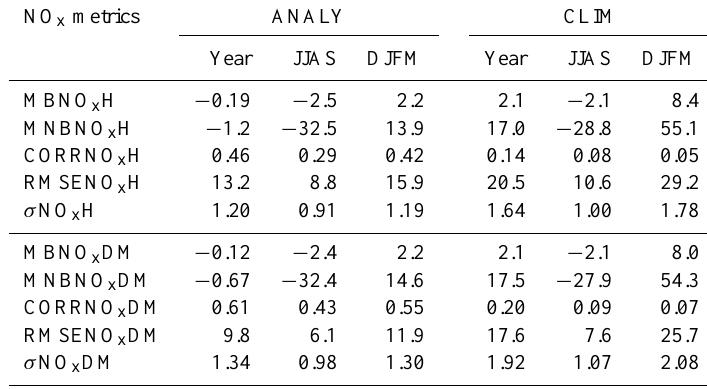
Table 7. Same as Table 6 for hourly value and daily mean NO x concentrations.